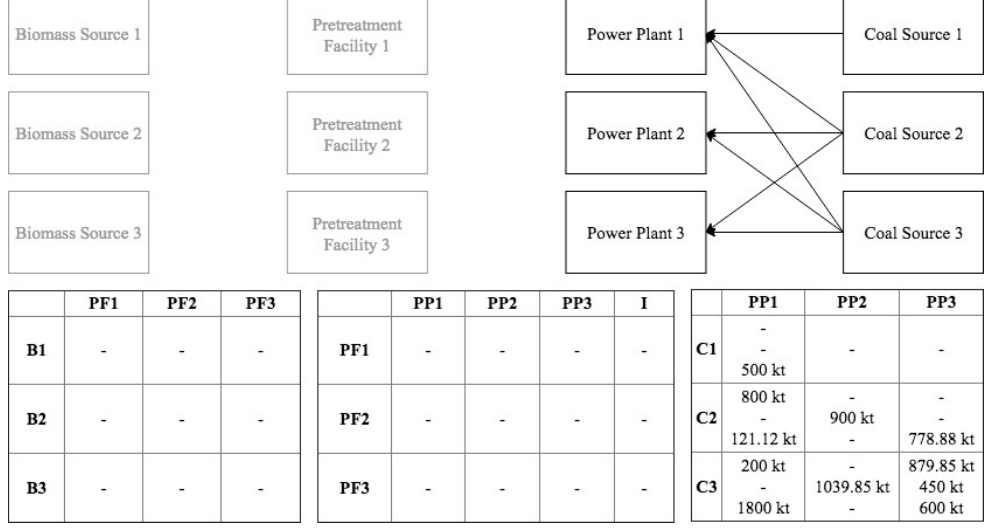
Figure 4. Minimum Cost Network. Table 7. Comparison of costs and emissions objective performances.